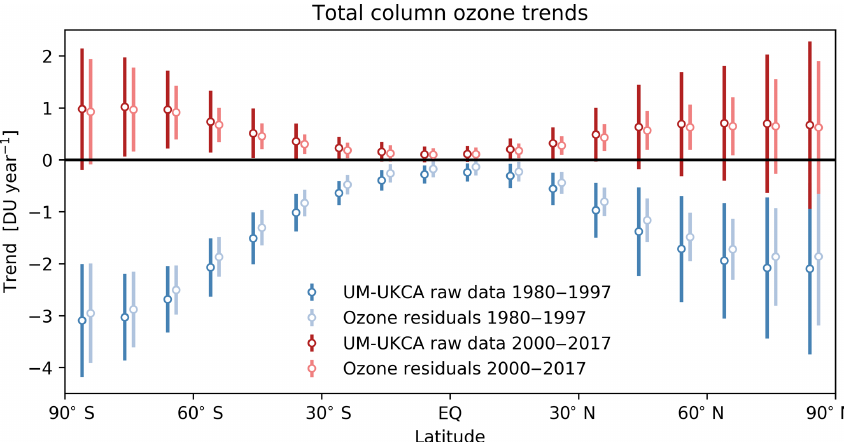
Figure 2. Ozone trends from 1980 to 1997 (blue points) and 2000–2017 (red points) for the raw UM-UKCA data (dark points) and ozone residuals calculated when the effects of natural cycles are removed (light points). Error bars associated with each trend represent the 95% confidence intervals, calculated as described in Sect.